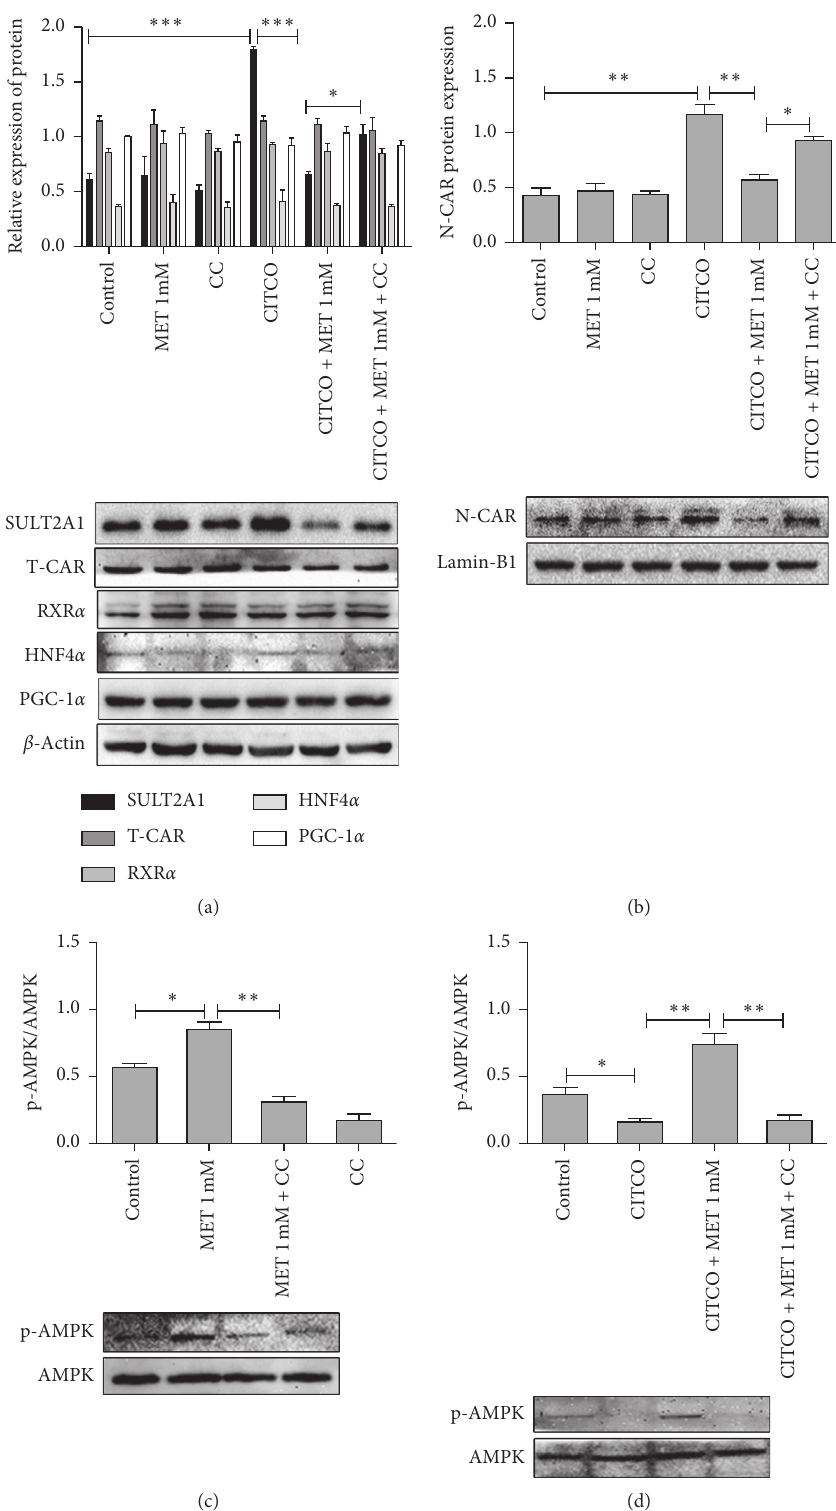
Figure 5: Regulation of CAR and SULT2A1 by metformin is dependent on the activation of AMPK pathways. HepaRG cells were preincubated with compound C (CC; 20 μ M) for 90 min before the treatment with metformin (1mM), CITCO (1 μ M), or their combi- nations. Cells treated only with DMSO were considered as the control group. Cells were then lysed and analyzed for western blotting against SULT2A1, T-CAR, RXR α , PGC-1 α , HNF4 α , β -actin (a), N-CAR, lamin-B1 (b), AMPK, and p-AMPK (c, d). A representative blot was shown and quantified by Image J software. The data shown are the mean ± SEM ( n � 3) ( ∗ P < 0 . 05, ∗∗ P < 0 . 01, and ∗∗∗ P < 0 . 001, comparison indicated by